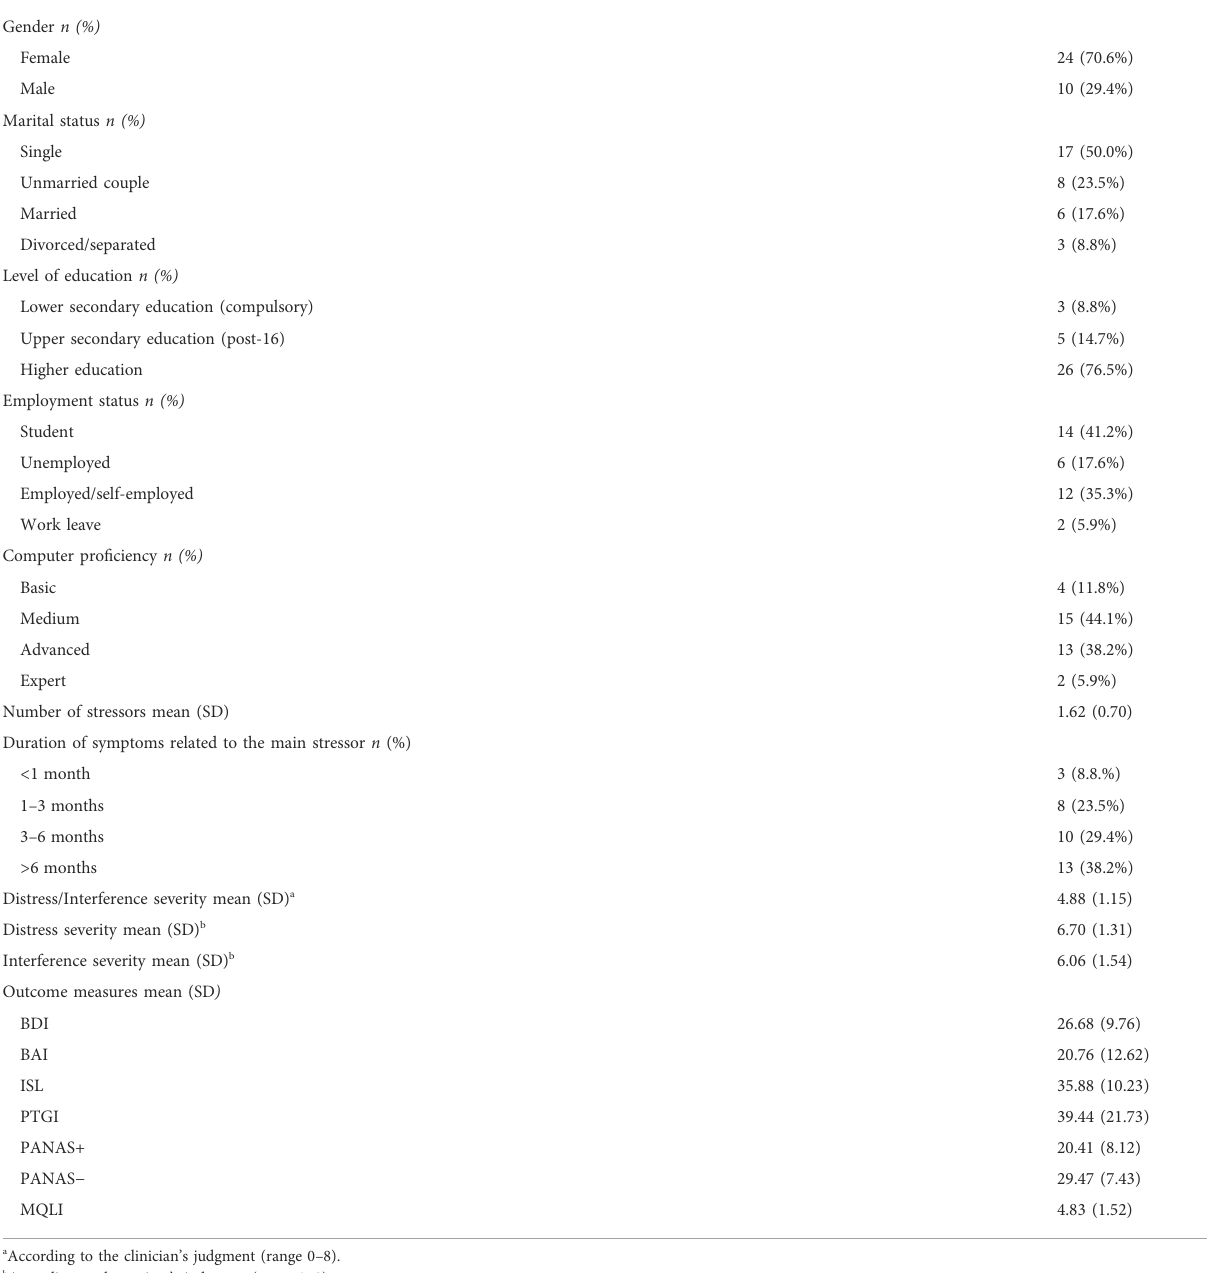
TABLE 1 Characteristics of study participants at